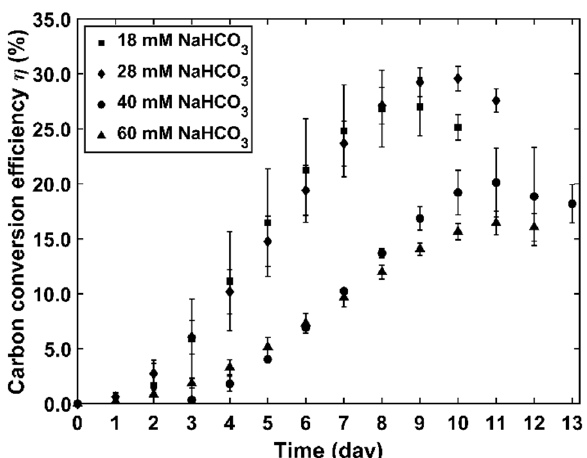
Figure 5. Conversion efficiency of inorganic carbon provided as NaHCO3 into organic carbon as per Equation (2).